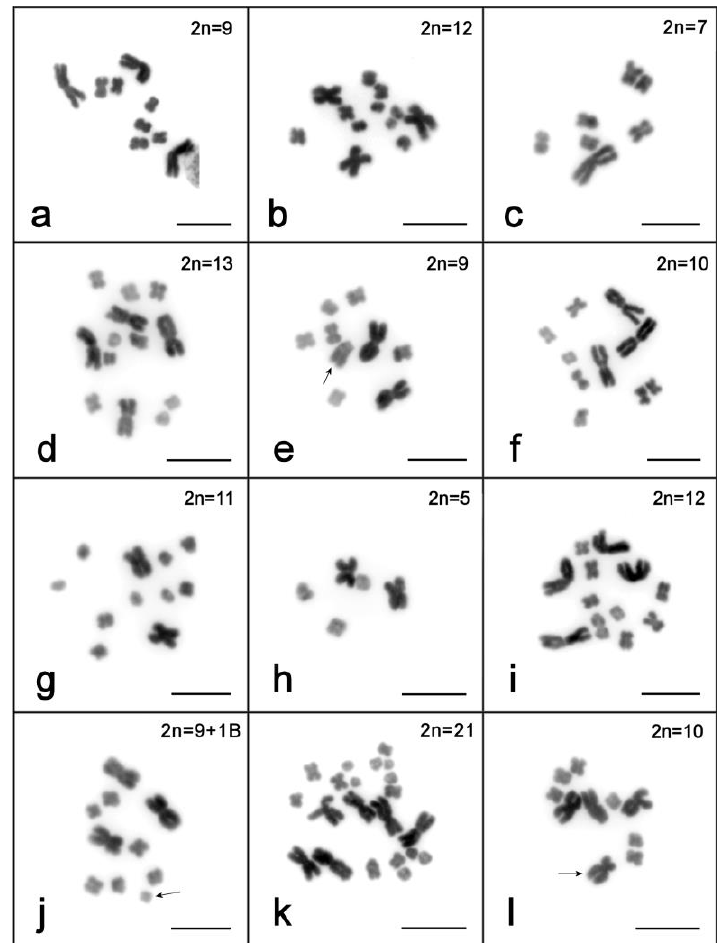
Figure 3. Karyotype variation in M. mirumnovem specimens: ( a ) karyotype 9, – MMI1; ( b – l ) karyotypes different from 9, – MMI1. ( b ) 2 n = 12 (three large and nine small metacentrics); ( c ) 2 n = 7 (one large and six small metacentrics); ( d ) 2 n = 13 (four large and nine small metacentrics); ( e ) 2 n = 9 (two large and six small metacentrics and one medium-sized submetacentric, marked with an arrow); ( f ) 2 n = 10 (three large and seven small metacentrics); ( g ) 2 n = 11 (two large and nine small metacentrics); ( h ) 2 n = 5 (two large and three small metacentrics); ( i ) 2 n = 12 (four large and eight small metacentrics); ( j ) 2 n = 9 + 1B (three large and six small metacentrics and one B chromosome, marked with an arrow); ( k ) 2 n = 21 (six large and 15 small chromosomes); ( l ) 2 n = 10 (three large metacentrics and six small metacentrics, and one medium-sized submetacentric, marked with an arrow).